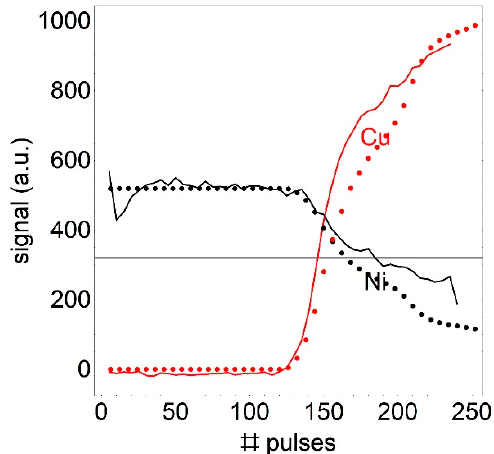
Figure 3. Average intensity of the selected Ni and Cu-lines as a function of the number of laser pulses for a 5 µm thick nickel coating, ablated with 10 ps pulses. Dotted lines are simulated based on the measured ablation profile.